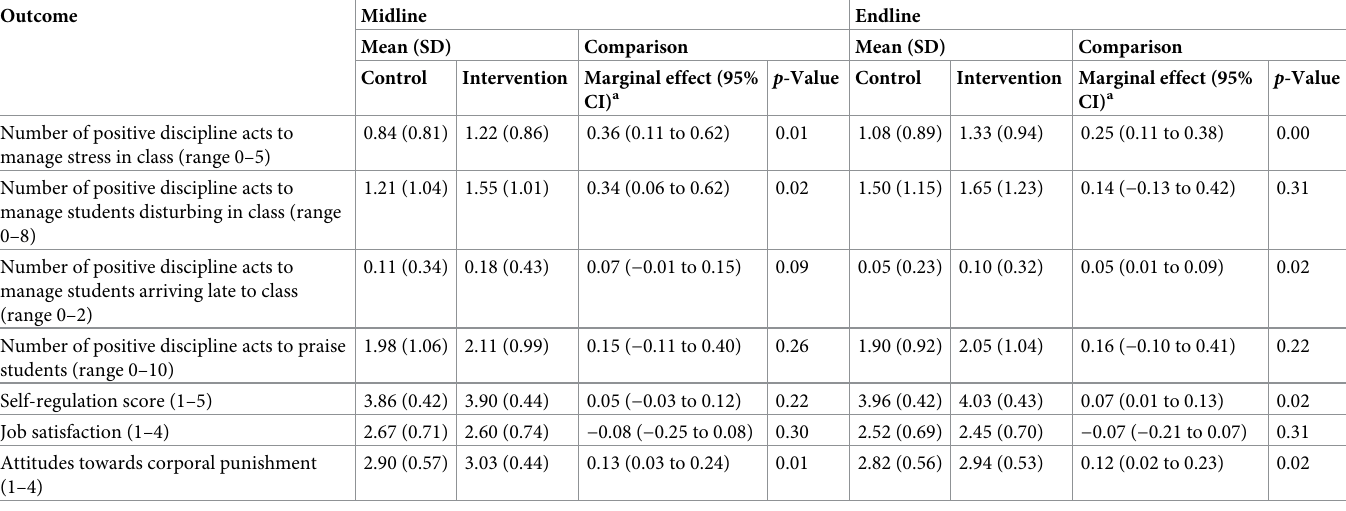
Table 5. Exploratory analyses of intermediate outcomes for teachers.